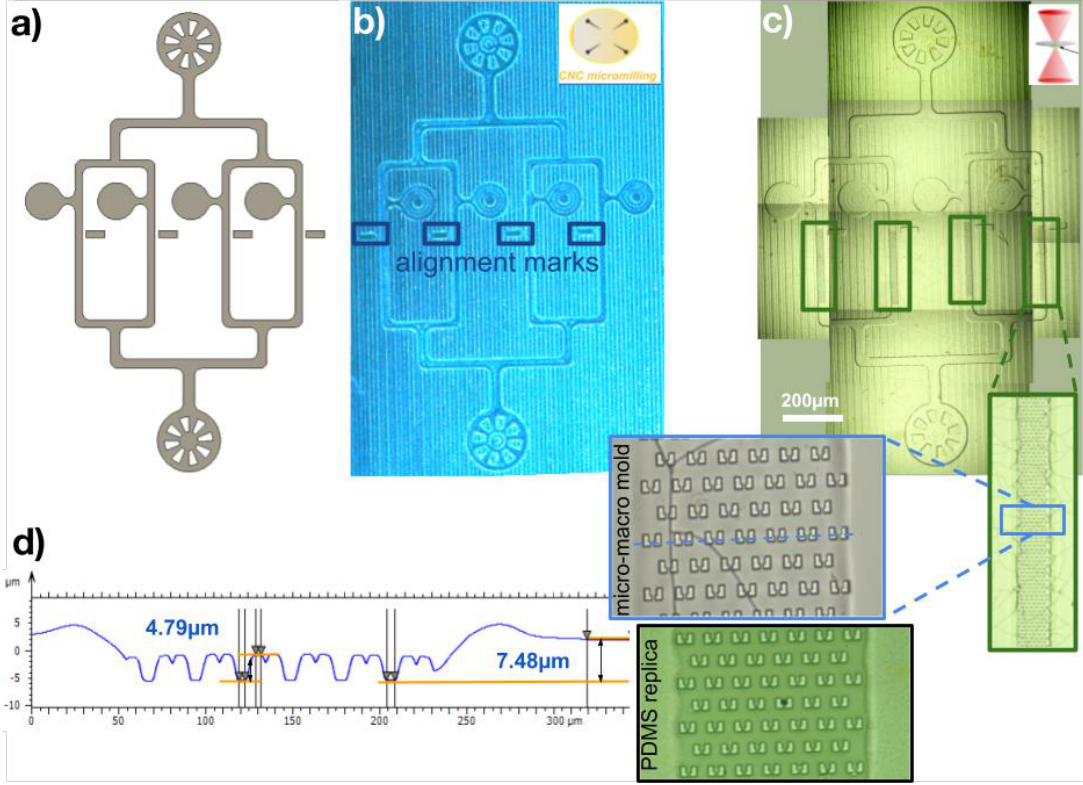
Figure 6. Fabrication process of a master mold for a microfluidic platform replicating an existing one for yeast trapping and study [28]. From a full design including both low- and high-resolution features ( a ), a PMMA sample is first processed using CNC micromilling ( b ) and then transferred to the 2PP system for the fabrication of the microtraps locally, inside a designated small-area of the microchannels ( c ). Although PMMA cleaning with alcohol may generate internal cracks, it was found that the cracks were not transferred in any area of the PDMS replica. ( d ) The surface profile of the PDMS surface, shows the integrity of the microtraps on the